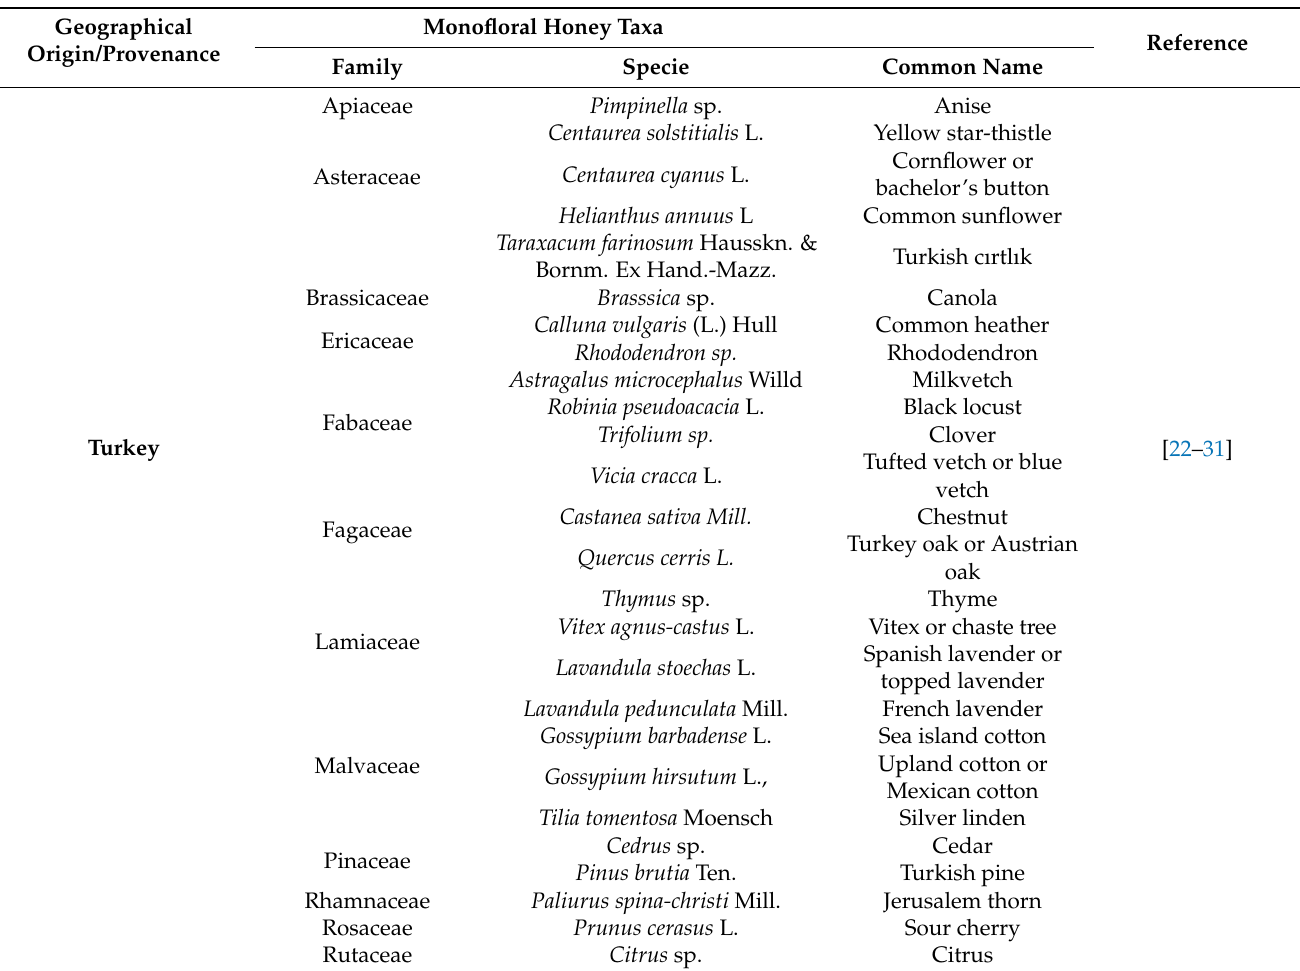
Table 1. Monofloral honeys taxa based on